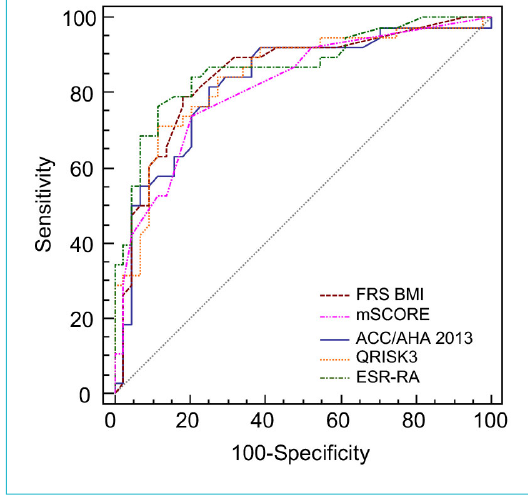
Figure 1: Receiver operating characteristic curves of the different risk prediction algorithms. The curves plot the relationship between sensitivity and complement of specificity of each risk score for dif- ferent cut-off levels of test positivity.ESR-RA = Expanded Risk Score in Rheumatoid Arthritis; ACC/AHA 2013 = American College of Cardiology/American Heart Association 2013 calculator; FRS BMI = Framingham Risk Score using body mass index; mSCORE = modified Systematic Coronary Risk